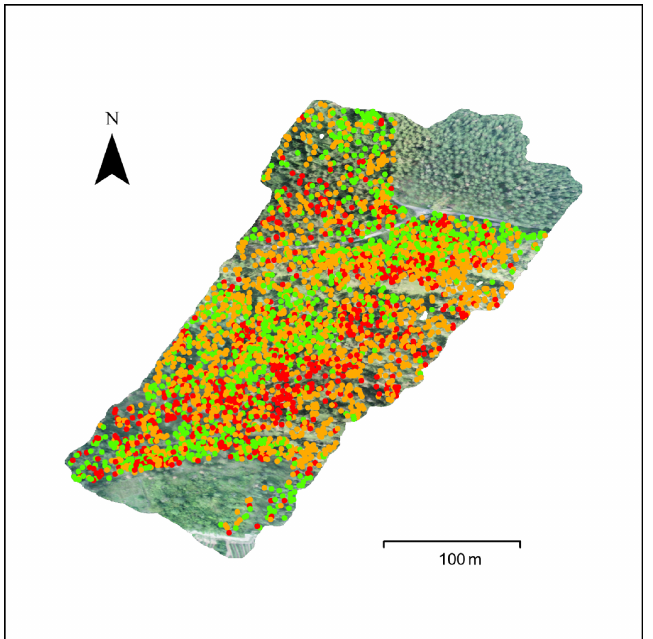
Figure 6. The result after post-processing the output of the final model extensively covers the area of interest in one orthomosaic. Each point represents a tree classified as either a healthy black pine (green), a damaged black pine (orange), or a dead black pine (red). The result coincidentally contains no tree classified into another conifer species or a deciduous